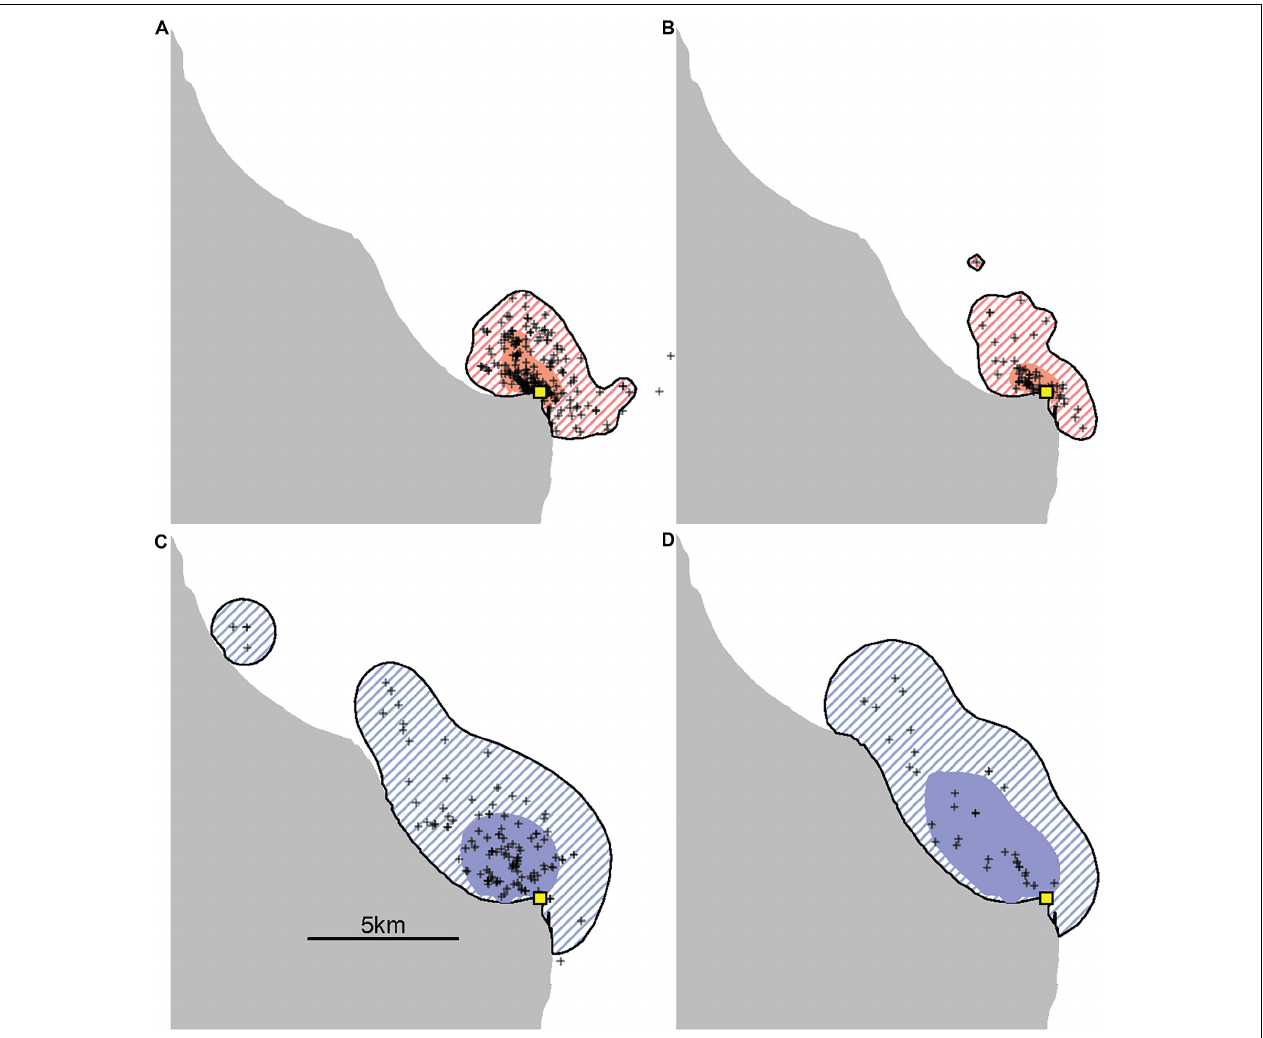
FIGURE 5 | An example of the effects of provisioning on the ranging patterns of an adult female. Kiya (top) is the offspring of a provisioned female and began accepting fish herself in 2016 when she was 18 years old, well into adulthood. This is contrasted with her paternal half-sister, Rhombus (bottom), who was born the same year and is also a seagrass specialist, but who is neither provisioned nor the offspring of a provisioned female. Using all available adult sightings excluding consortships (range 33–228 per panel) the size of Kiya’s 95% kernel contour decreased from 14.8 km 2 before (A) to 11.3 km 2 after (B) the start of provisioning, while her 50% kernel contour decreased from 2.8 km 2 to only 1.3 km 2 . During the same time periods, her sister Rhombus had 95% kernel contour areas of 44.8 km 2 (C) and 43.8 km 2 (D) and 50% kernel contour areas of 7.7 and 12.9 km 2